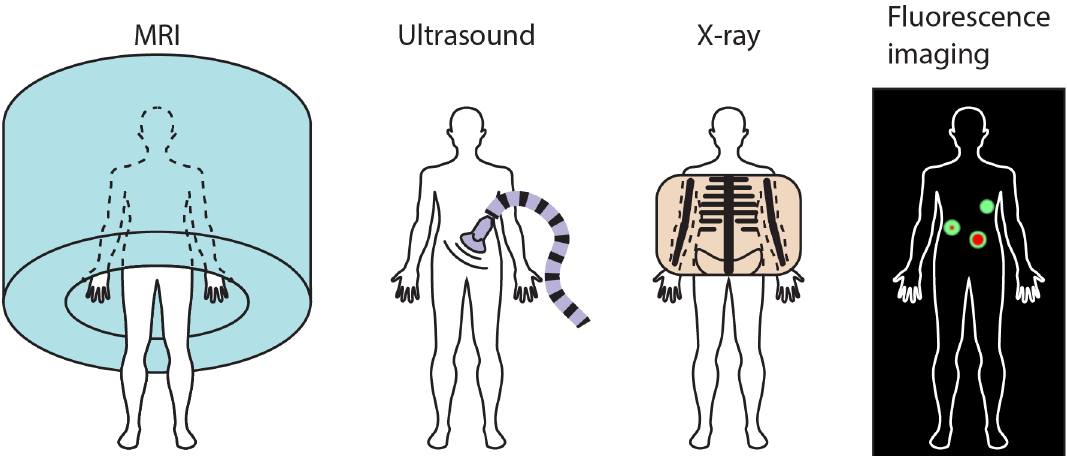
Figure 2. Schematics of four exemplar medical imaging modalities that are relevant with small-scale magnetic robots. They are magnetic resonance imaging (MRI), ultrasound (US), X-ray, and fluorescence